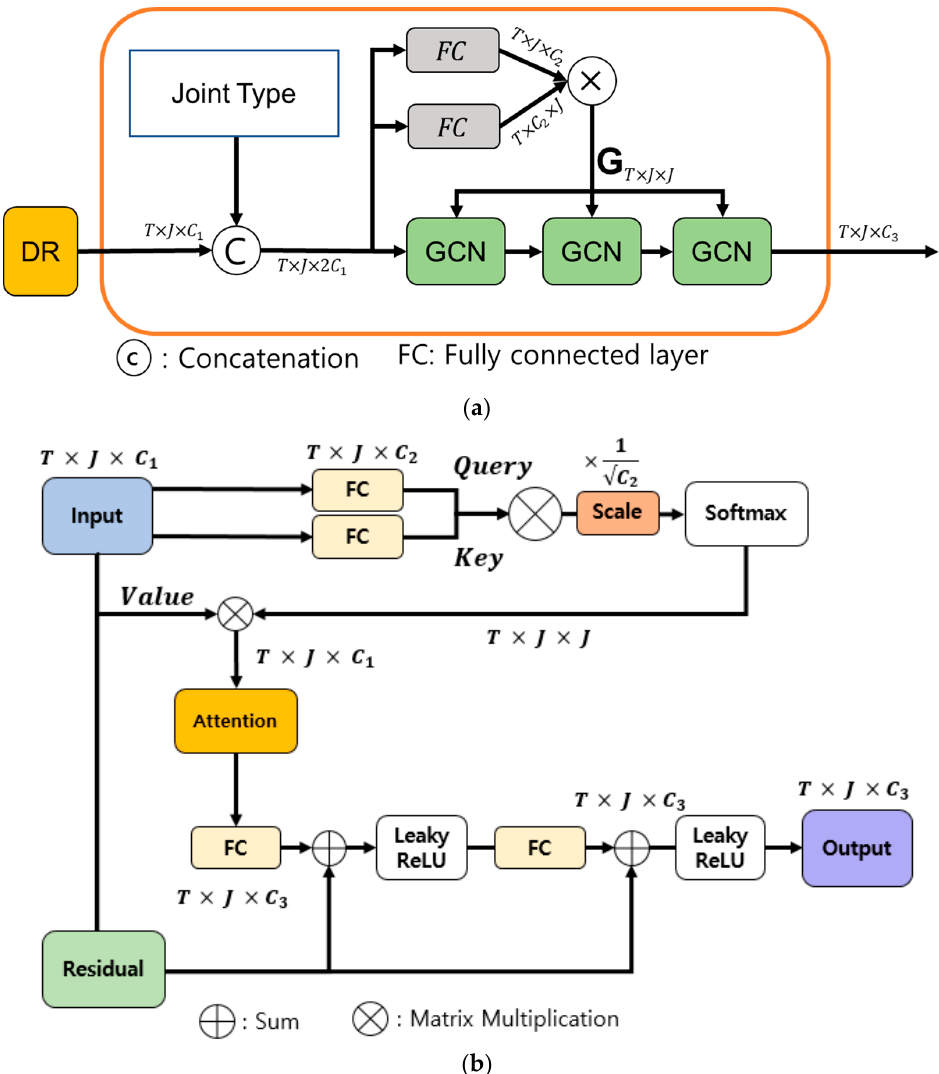
Figure 2. Illustration of the joint-level module of ( a ) original SGN based on a GCN and ( b ) the proposed SHA. ( a ) The output of the DR and the joint type vector are concatenated to create a joint-level feature through three consecutive GCNs. ( b ) A joint-level feature is created that emphasizes important joints through four one-layer FCs and a residual network.